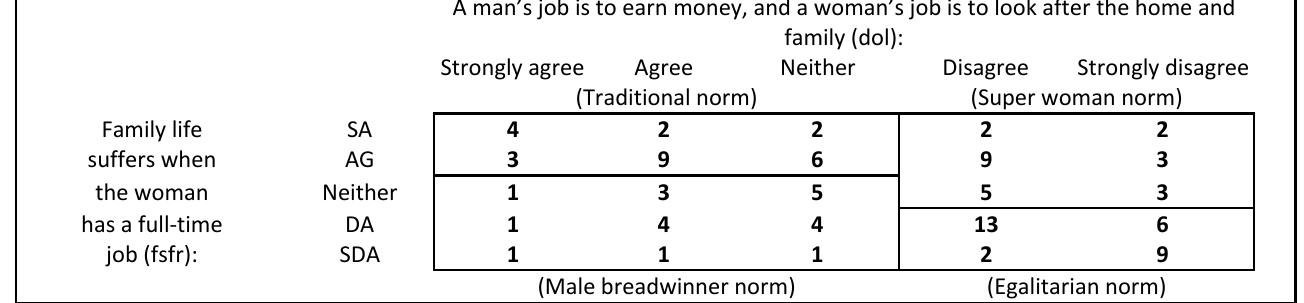
Figure 1. Typology of gender role norms based on two attitude questions (numbers show the percentage distribution in the sample).